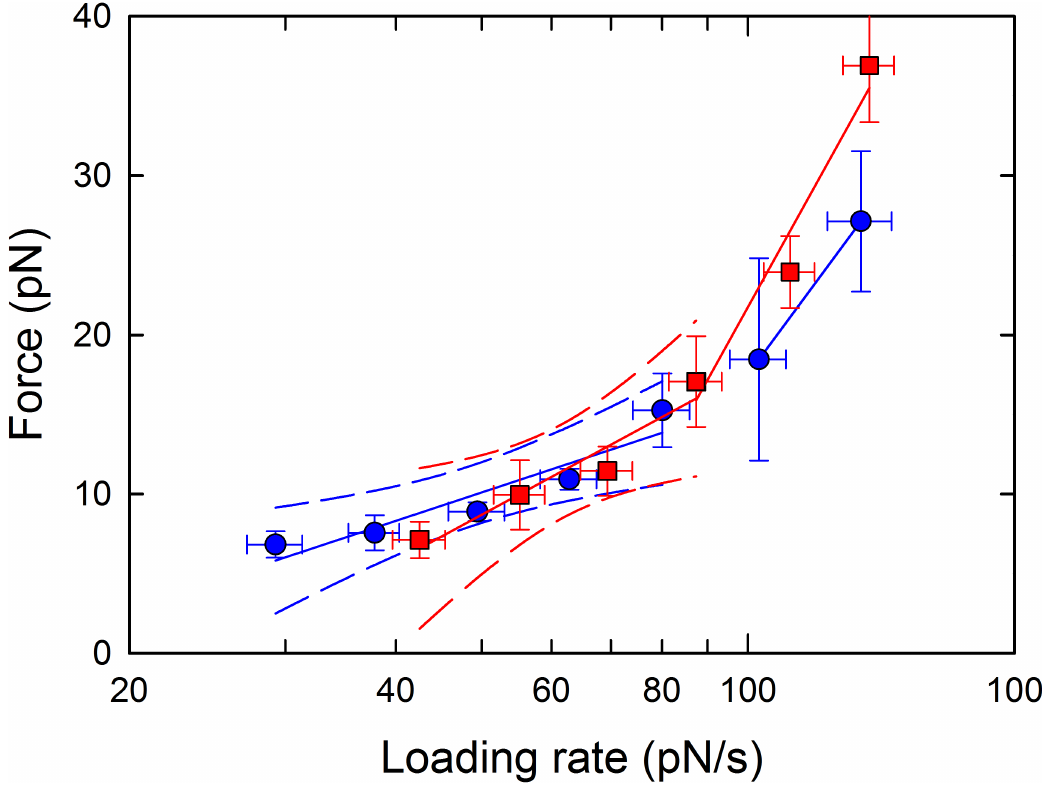
Fig 5. Dynamic force spectrafor the MUC1(Tn)–MGL (blue points) and for MUC1(STn)–MGL (red points). The most probableunbinding forces f * (large points) were determinedfrom the fit of Eq 2 to the histograms depictedin Fig 4A and 4C, and were plotted versus increasing force loadingrate.The data points are depictedwith symbols for the mean values and error bars representingthe spread of r f in the intervals(standard deviation)and standarddeviationof f * being the uncertaintyof the estimates. The continuous lines depict the result of a linear regression performed for the data containedwithin each linear regime of the dynamic force spectrum. The discontinuous lines depict the 95% confidence intervals of the linear